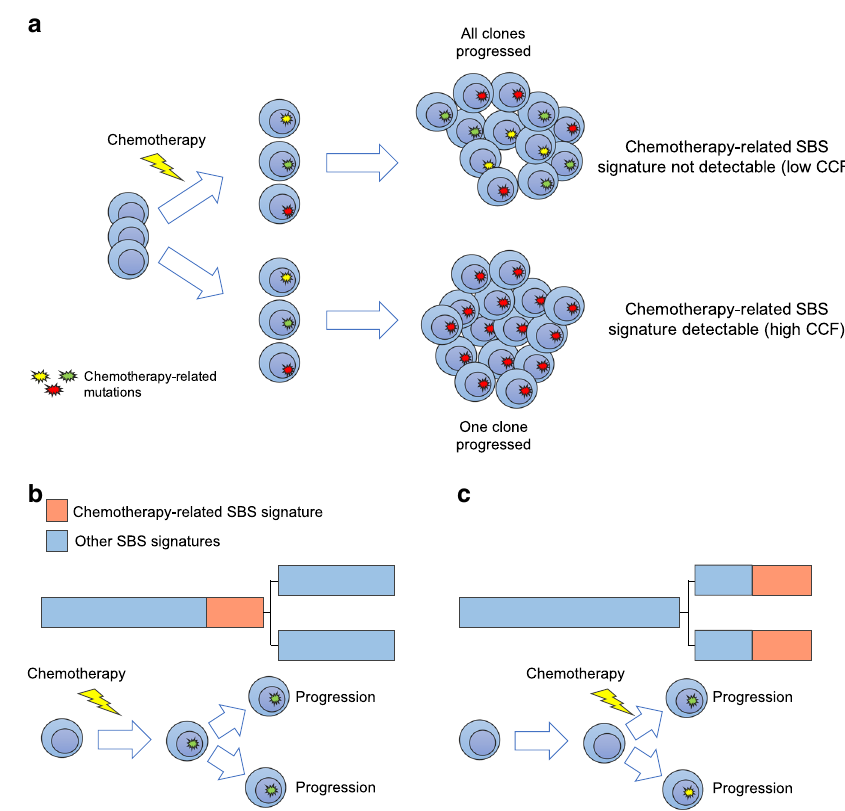
Fig. 1 The development of chemotherapy-related mutational signatures. a A schema summarizing the single cell expansion model. In this model, chemotherapy-related mutational signatures will be detectable only if one cancer cell is selected and takes the clonal dominance. (SBS = single base substitution; CCF = cancer-cell fraction). b , c Two possible scenarios for the development of chemotherapy-related mutational signatures in two different disease localizations. In ( b ), chemotherapy is delivered to the trunk of the phylogenetic tree prior to any branching, while in ( c ) chemotherapy is delivered after branching. The phylogenetic tree trunk and branch lengths represent the mutational